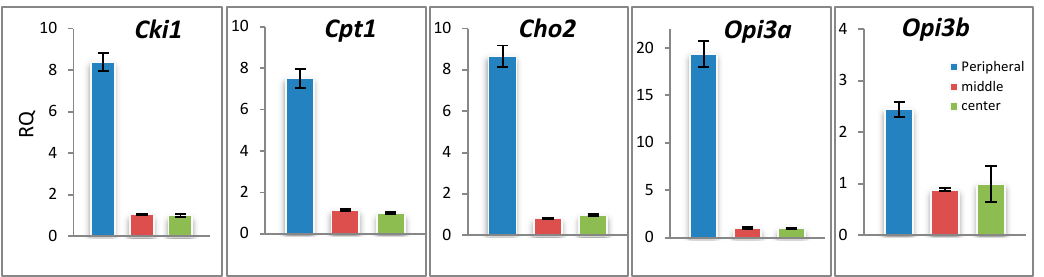
Figure 6. A comparison of the amino acid sequence of the two isoforms of F. velutipes Opi3 proteins. The PEMT domain is circled in green.